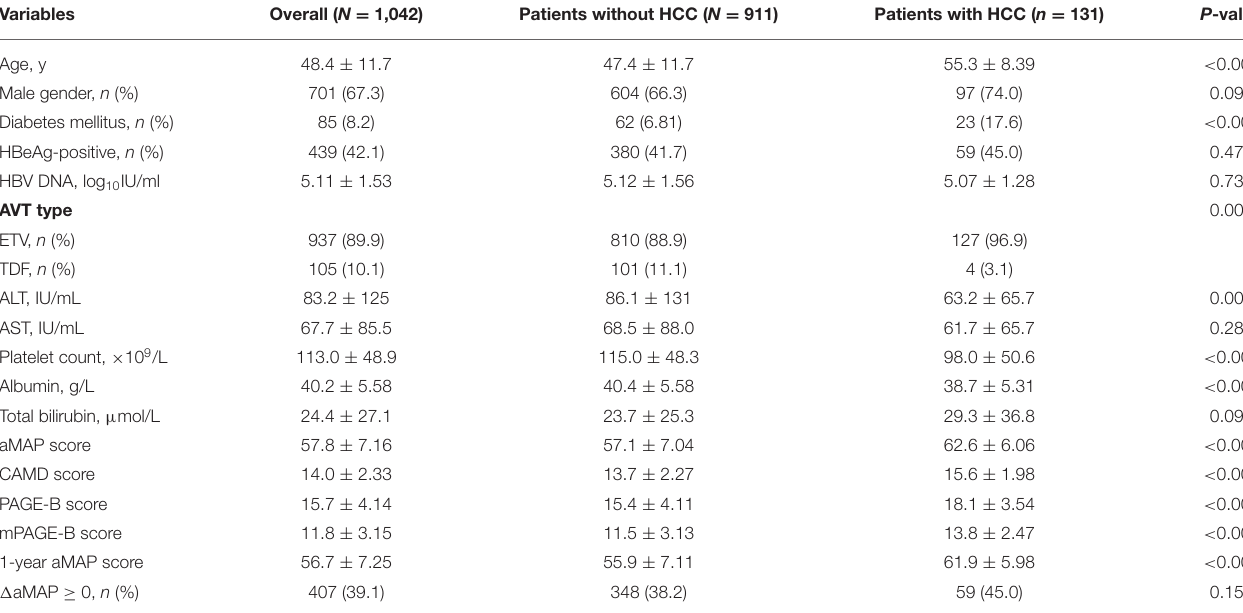
TABLE 1 | Baseline and on-treatment characteristics of the study